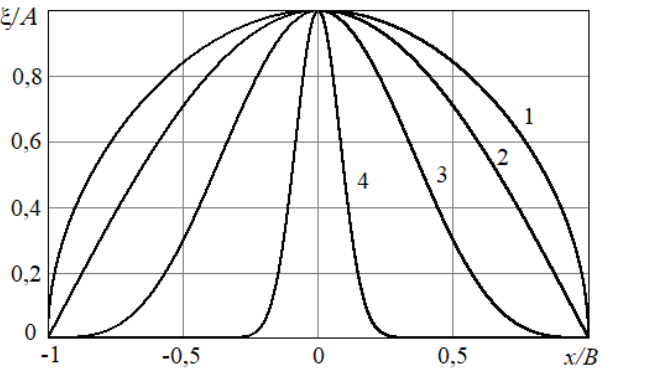
Fig. 7. Profile shape for various parameter values m : 1 – m = 0,5; 2 - m = 1; 3 - m = 3,5; 4 - m =